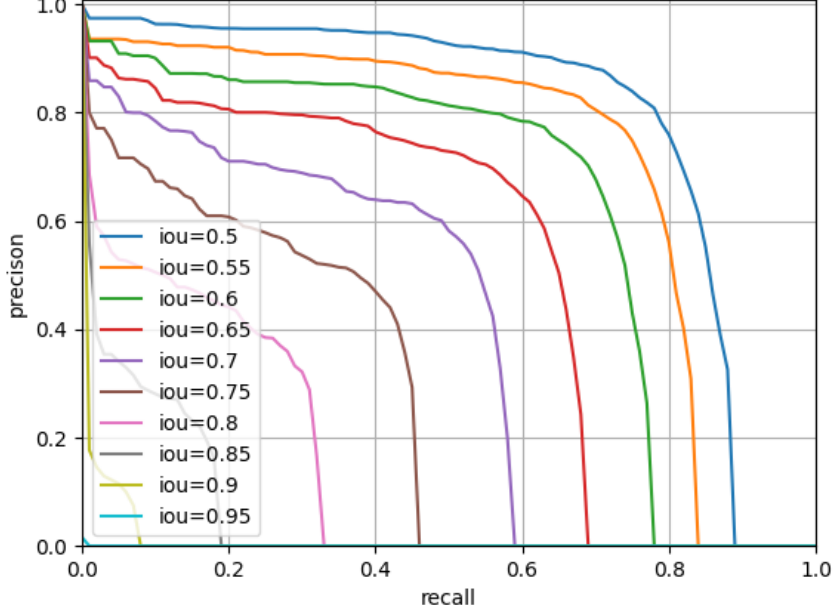
Figure 14. The PR curves of category bridge on HRRSD. The bridge is one of the categories of HRRSD. These curves are achieved by the EFNet as the different IoU s between the predicted boxes and the